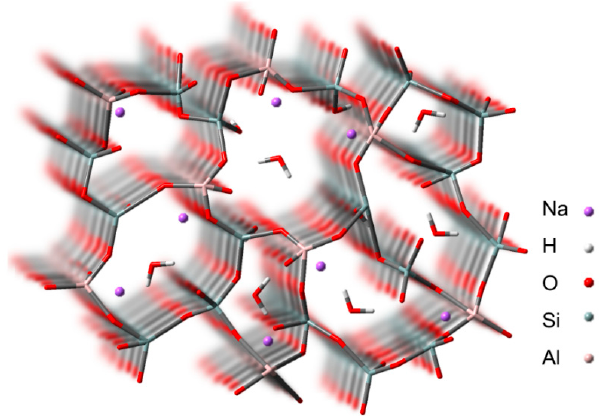
Figure 1. Schematic representation of the geopolymer framework.